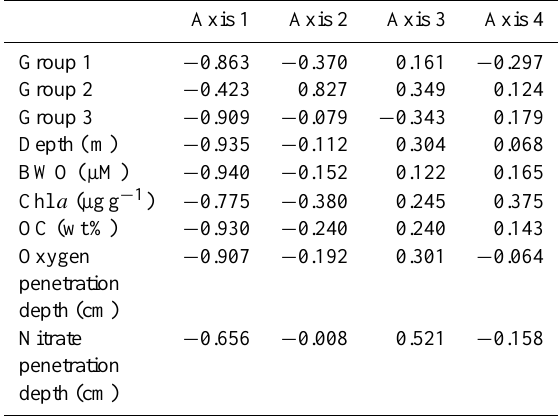
Table 1. Canonical correspondence analysis factor with the three groups defined by PCA and environmental components. The abbre- viation OC refers to organic carbon, Chl a to chlorophyll a concen- tration, BWO to bottom water